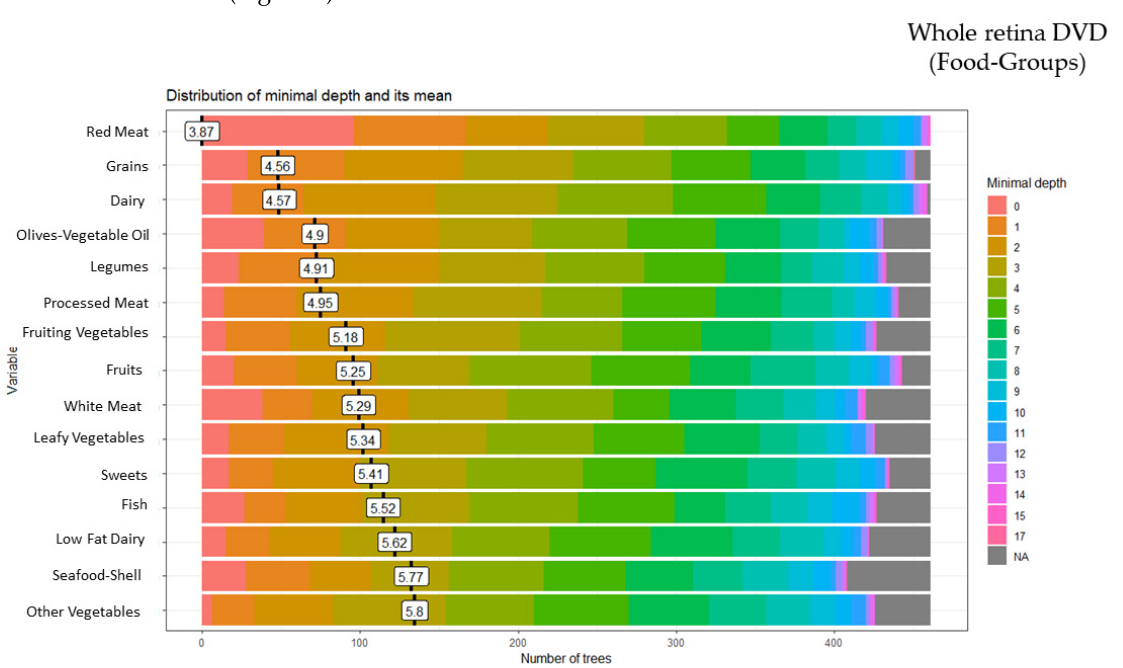
Figure 4. Random forest food group and whole retina deep vessel density (DVD).